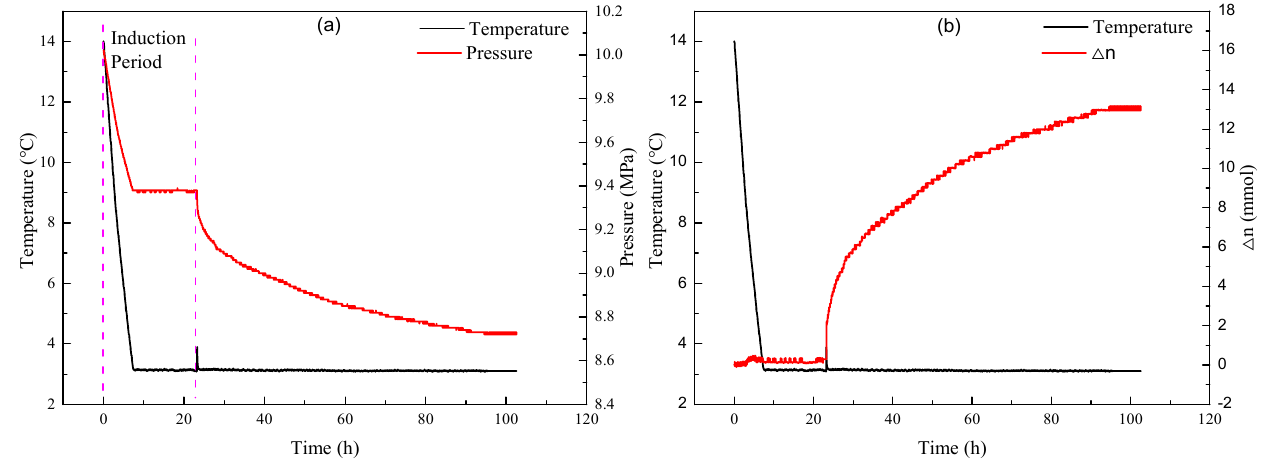
Figure 4. Typical hydrate formation curve. ( a ) Pressure and temperature evolution of methane hydrate formation. ( b ) Methane consumption and temperature evolutions of methane hydrate formation.